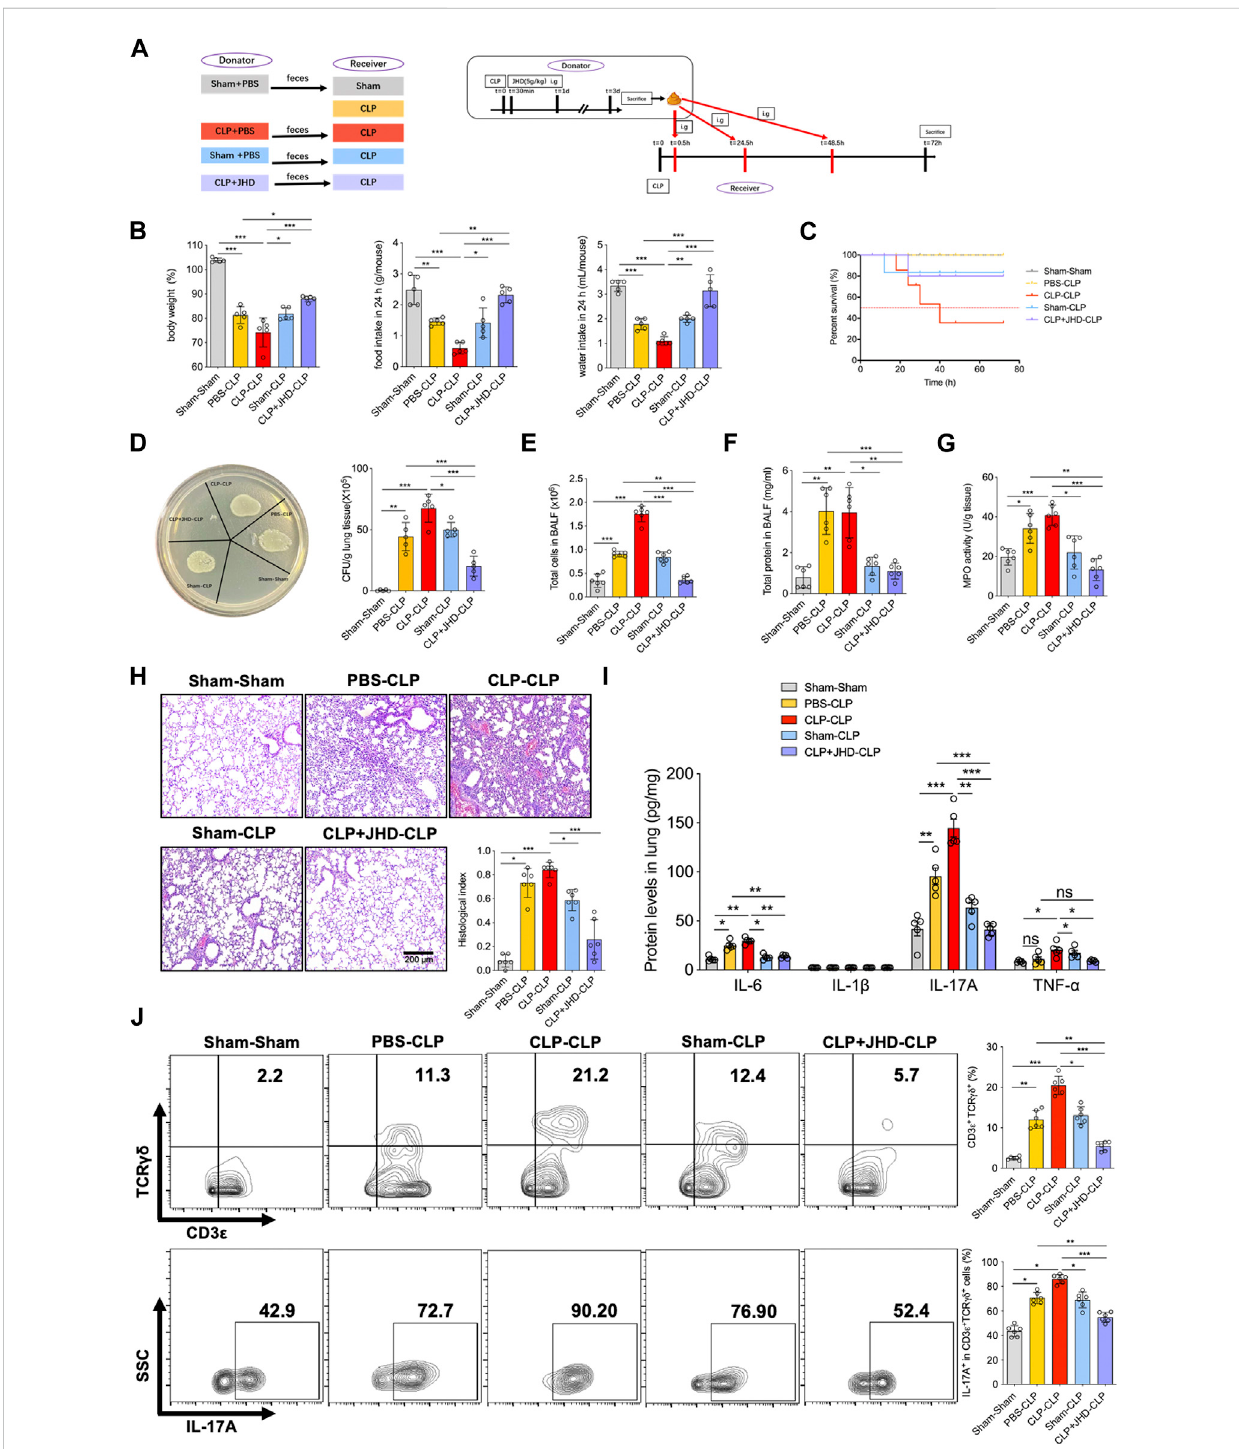
FIGURE 4 JHD confers the protective effect on sepsis-associated ALI via FMT. (A) Experimental fl ow chart; (B) Body weight, food consumption and water intake;and (C) SurvivalratesofmicewithdifferentFMT; (D) Bacterialloadinlungs; (E) Totalcellcounts,and (F) proteinleakageinBALF; (G) MPOactivityin lungs. (H) H&E staining of lung sections and correlated pathological scores (magni fi cation: ×400, scale bar = 200 μ m); (I) ELISA assays of the levels of in fl ammatory cytokines in lung homogenates; (J) CD3 ε + TCR γδ + γδ T (%) and IL-17A + γδ T (%) in BALF were analyzed by fl ow cytometry. (mean ± SD, n = 6, * p < 0.05, ** p < 0.01, *** p <